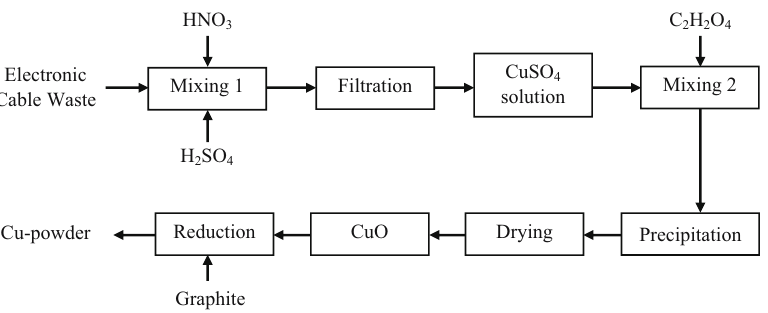
Figure 1: Making Cu powder from electronic cable waste fl ow chart.